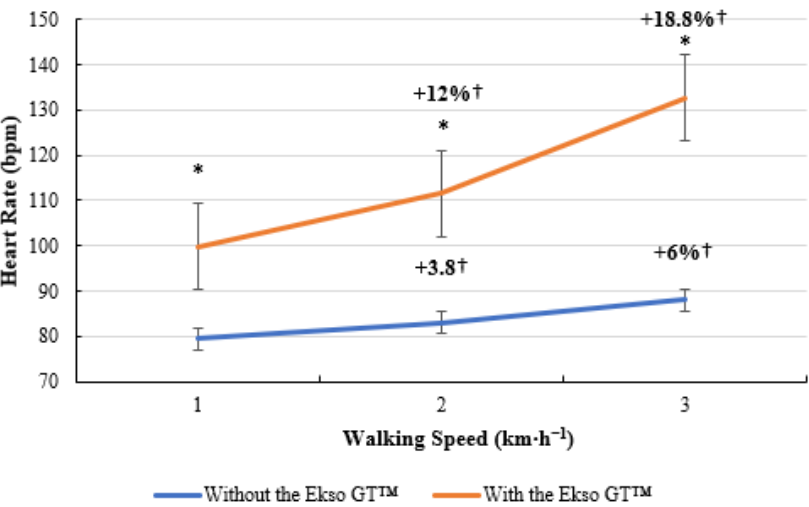
Figure 6. Heart rate (HR; bpm) data during treadmill walking with and without Ekso GT™. * Sig- nificantly greater ( p ≤ 0.05) when walking with Ekso GT™ versus walking with Ekso GT™. † Mean percentage HR increase at each walking phase with and without Ekso GT™.